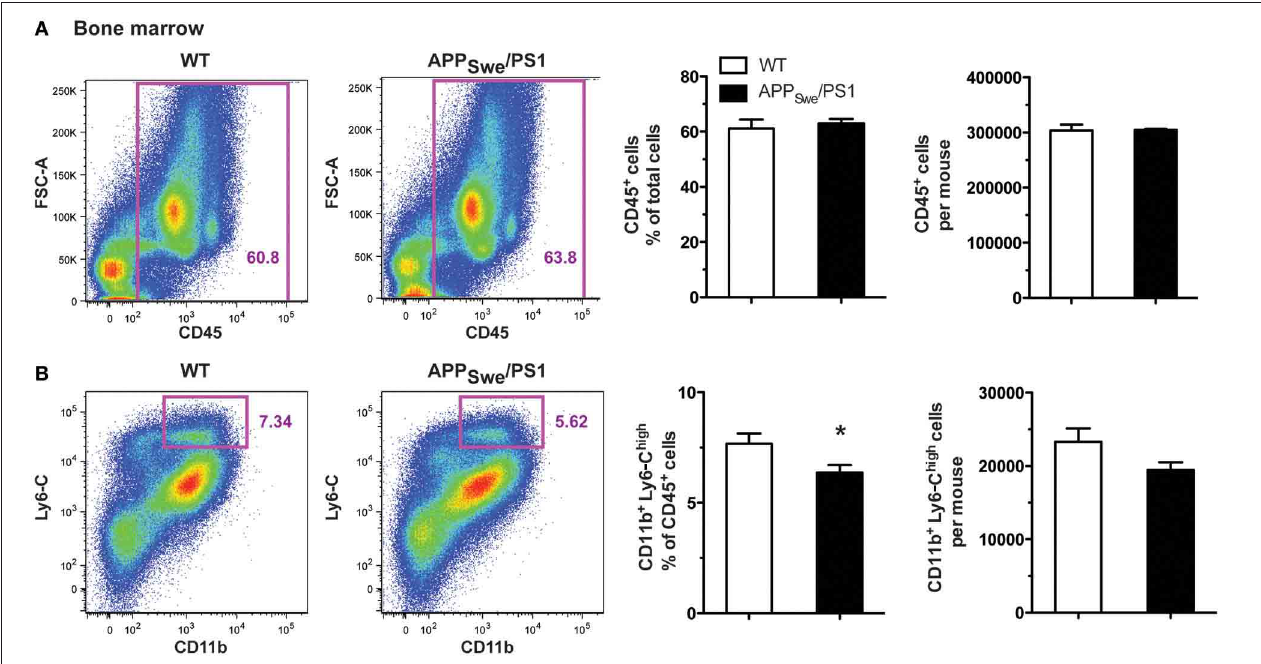
FIGURE 7 | Gr1 + Ly6-C high CCR2 + monocyte frequency is diminished in the bone marrow of 6-month-old APP Swe /PS1 mice. Leukocytes and Gr1 + Ly6-C high CCR2 + monocytes were quantified by FACS analysis in the bone marrow of WT and APP Swe /PS1 mice at 6 months of age. The leukocyte population was assessed using the CD45 marker. At 6 months of age, WT and APP Swe /PS1 mice exhibited similar levels of leukocytes (A) .